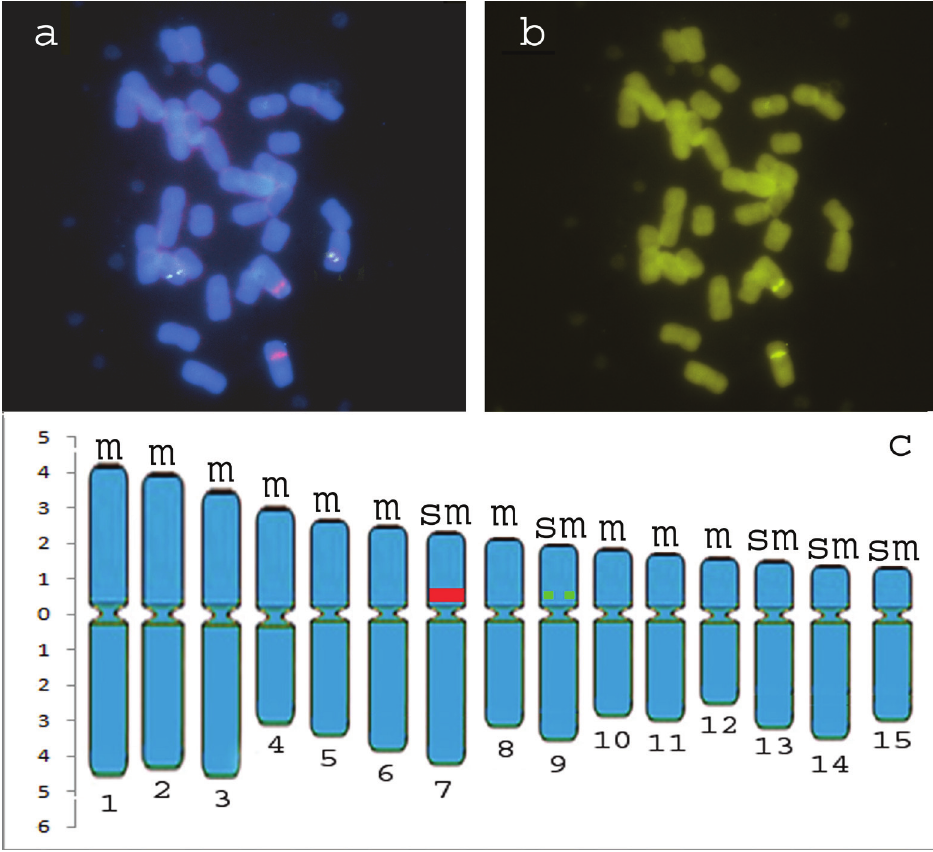
Figure 1 - Representative metaphases with 5S rDNA and 45S rDNA mapping (a) ; CMA pattern (b) and Ideogram of Agapanthus africanus (L.) Hoffmanns (c) (green squares= 5S rDNA, red rectangle = 45S rDNA), m = metacentric and sm =